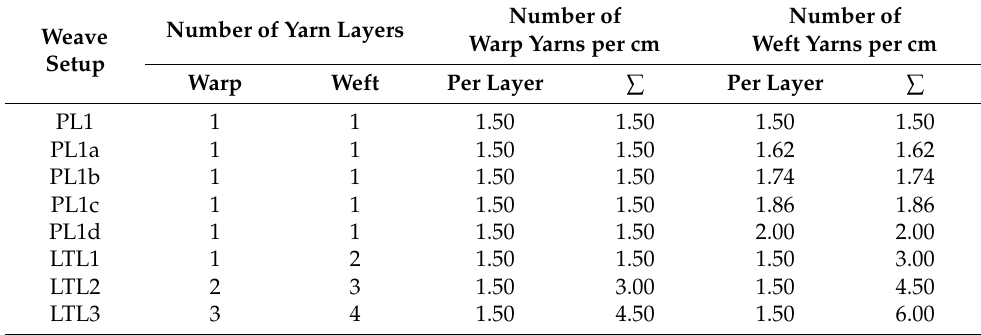
Table 1. Overview of examined woven fabric preform configurations.